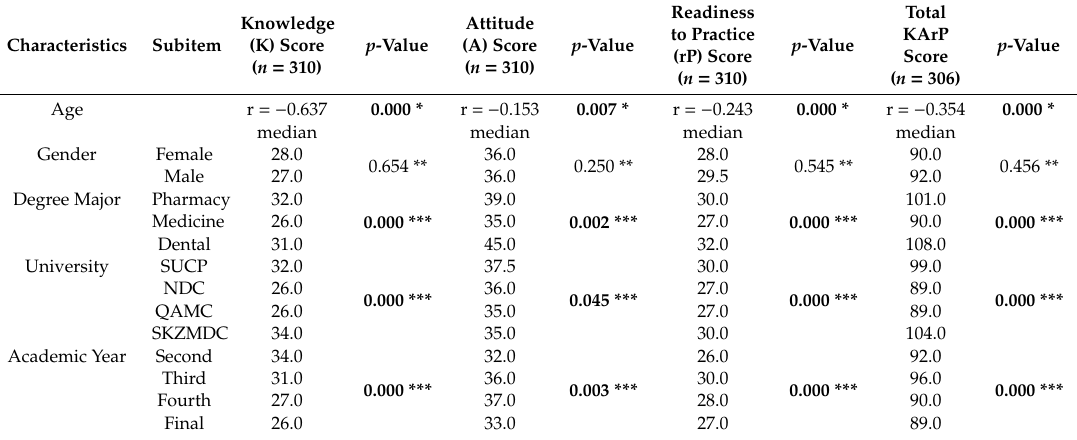
Table 2. Relationship between knowledge, attitude and readiness to practice scores with the respondents’ demographic and academic